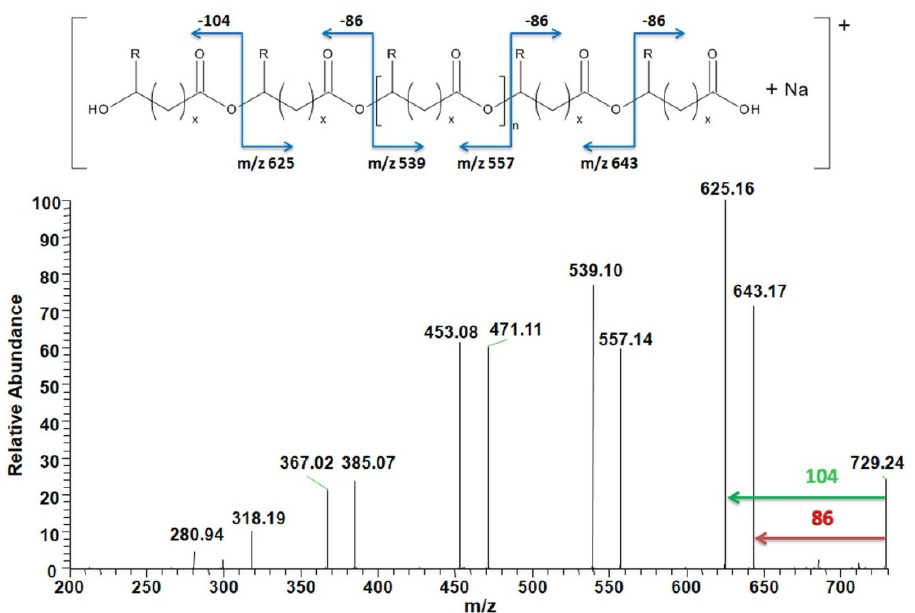
Figure 8. ESI–MS/MS fragmentation experiment for the ion at m/z 729 of oligo(3HB- co -4HB)/30WF after 70 days of degradation in water (for 3-HB units R = CH 3 and x = 1; for 4-HB units R = H and x = 2) (see Figure 7).